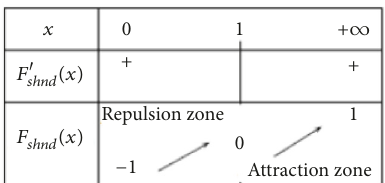
Figure 1: Change in measure normalizing function “Cost Multiply- ing”.